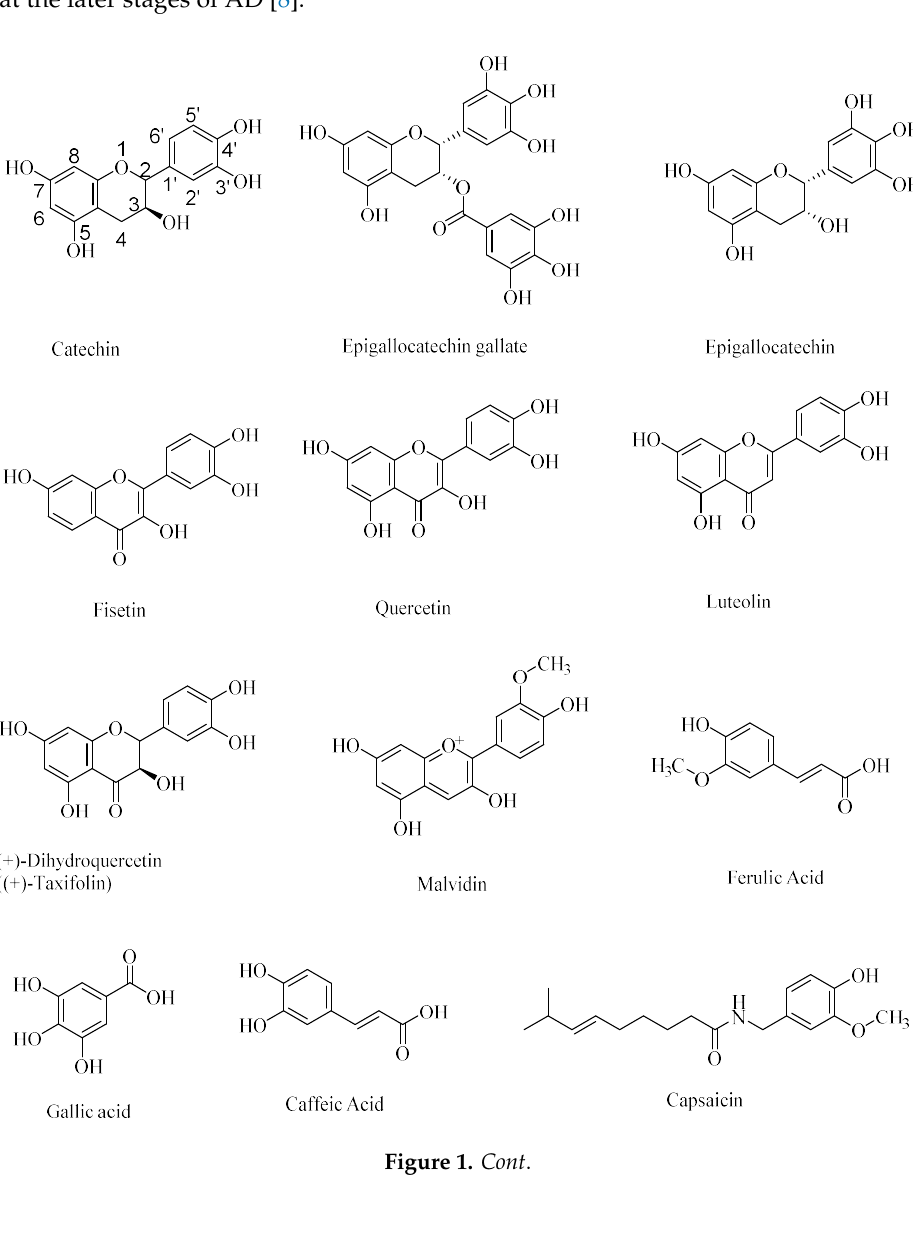
Figure 1. Structures of some of the naturally occurring polyphenolic compounds. 2. Polyphenols as Antioxidants The antioxidant behavior of polyphenols involves various mechanistic pathways, and in some cases, with multistep mechanisms. However, one of the widely accepted mechanisms for the antioxidant behavior of polyphenols is through free radical scavenging. The key structural feature of the radicals formed from the polyphenolic antioxidants is the extended conjugation of the unpaired electron, and thereby enhanced stability. This enables polyphenolic compounds to display